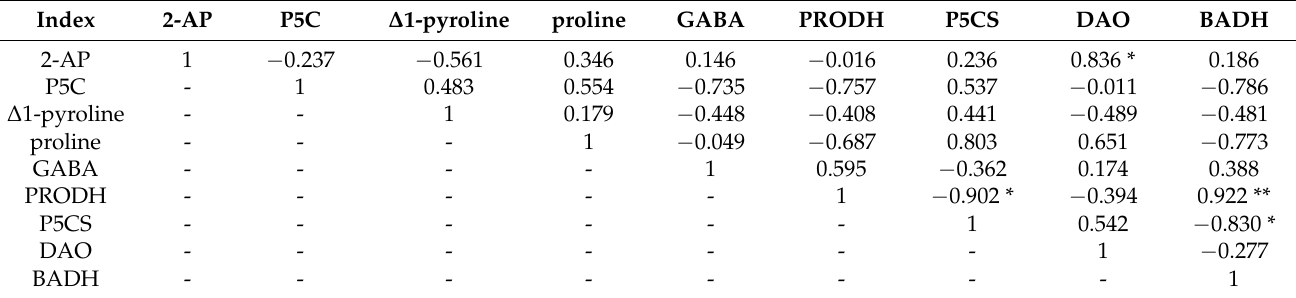
Table 2. Relationships among 2AP, enzymes and precursors of 2AP biosynthesis.